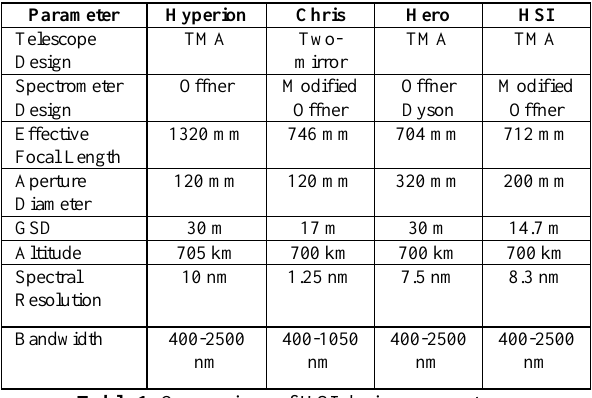
Table 1. Comparison of HSI design parameters